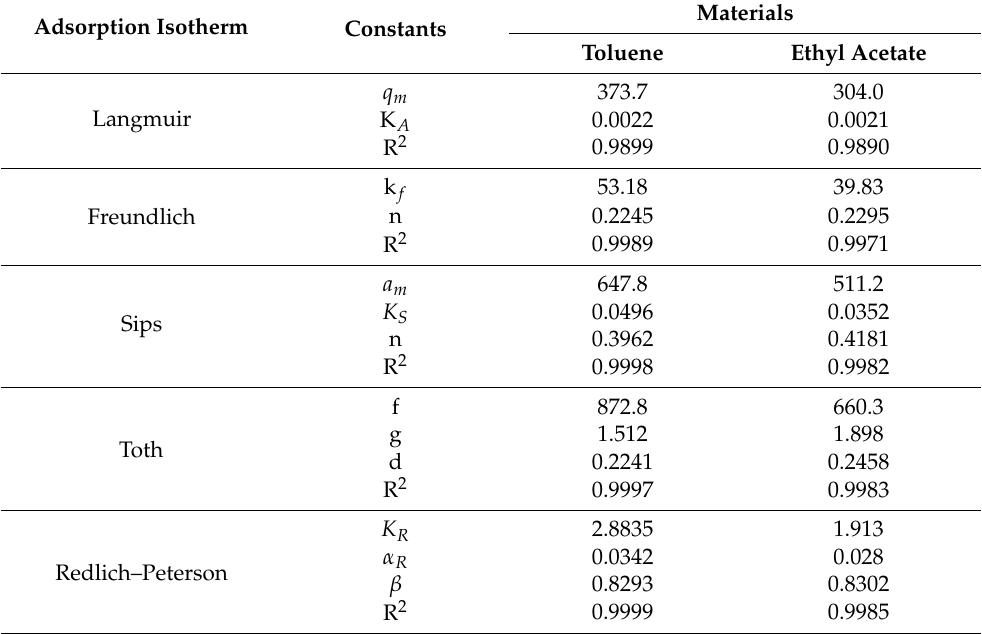
Table 3. Values of adsorption isotherm constants.